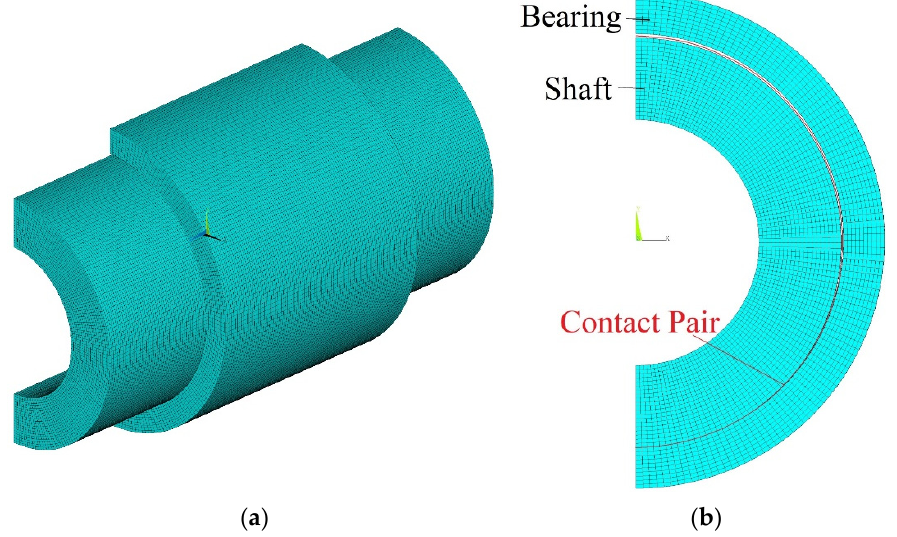
Figure 6. The finite element model of single bearing contact. ( a ) Global view of the model. ( b ) Cross- sectional view.